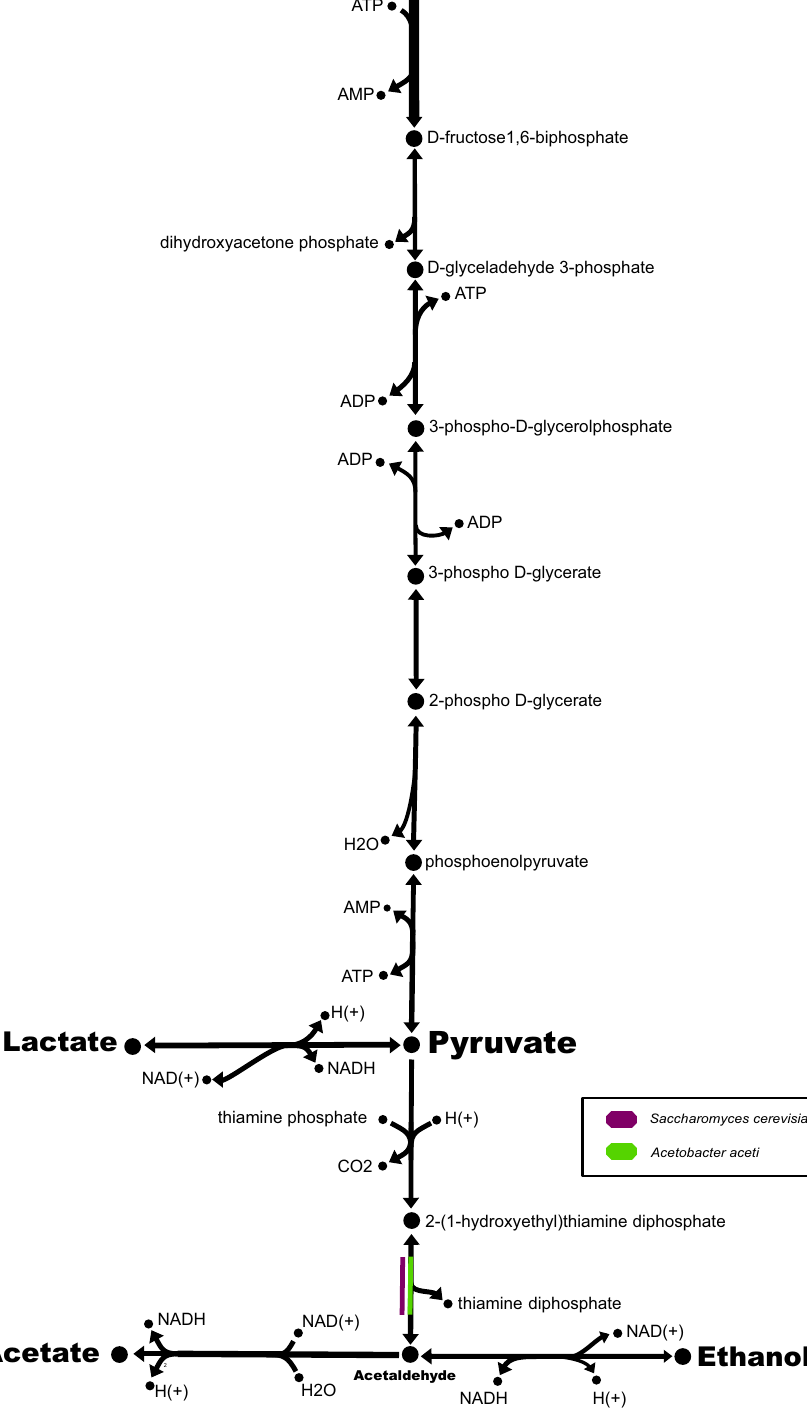
Figure 6. General metabolic network of the central carbon metabolism reconstructed at the community level. The genome-scale metabolic models of four dominant species shared between the studied farms (i.e. S. cerevisiae , B. subtilis , L. fermentum and A. aceti ) were used to reconstruct a metabolic community model for fine flavour cocoa fermentation. Production pathways for lactate, ethanol, and acetate are shown (bold-highlighted). Black arrows represent metabolic reactions occurring in all the four species. Colours were used to indicate reactions that took place only on the indicated